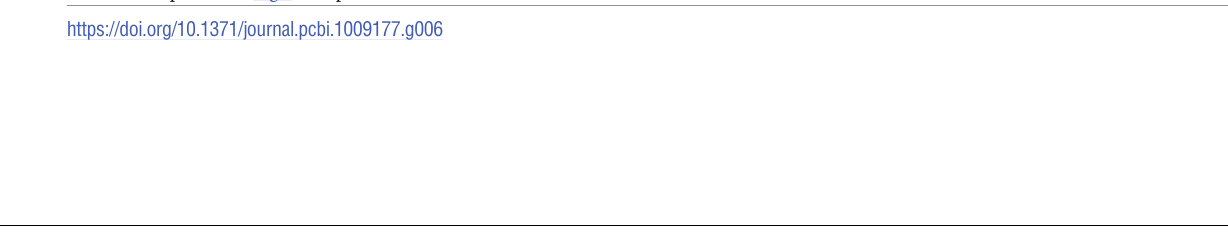
PLOS Computational Biology | https://doi.org/10.1371/journal.pcbi.1009177 July 8,